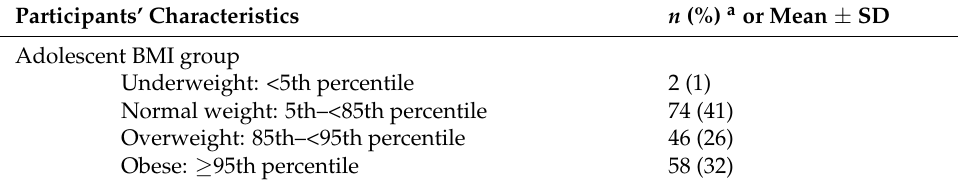
Table 1. Cont. Participants’